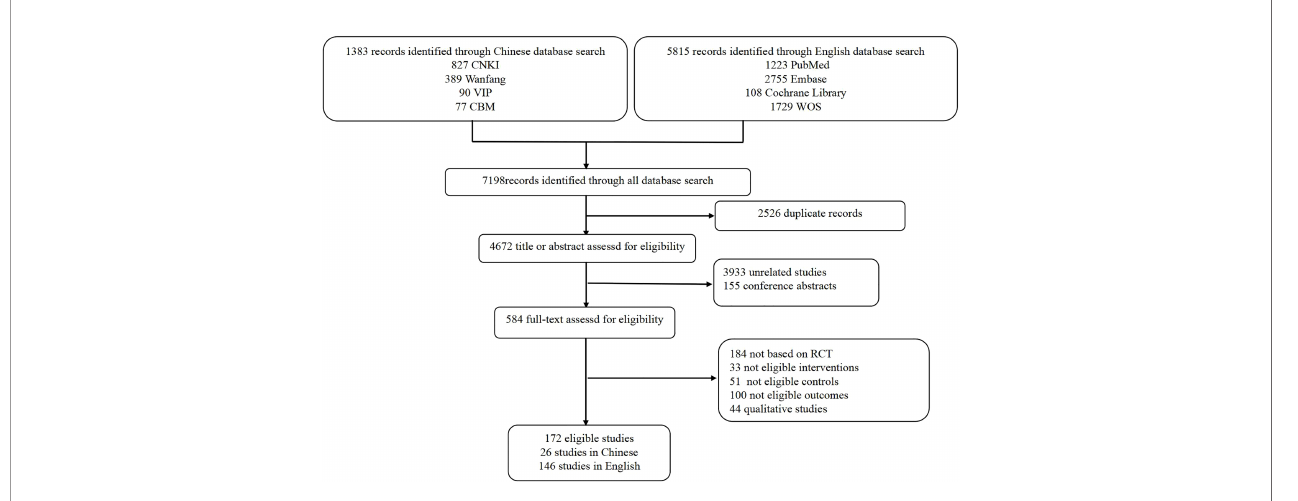
FIGURE 1 | Flow chart of study